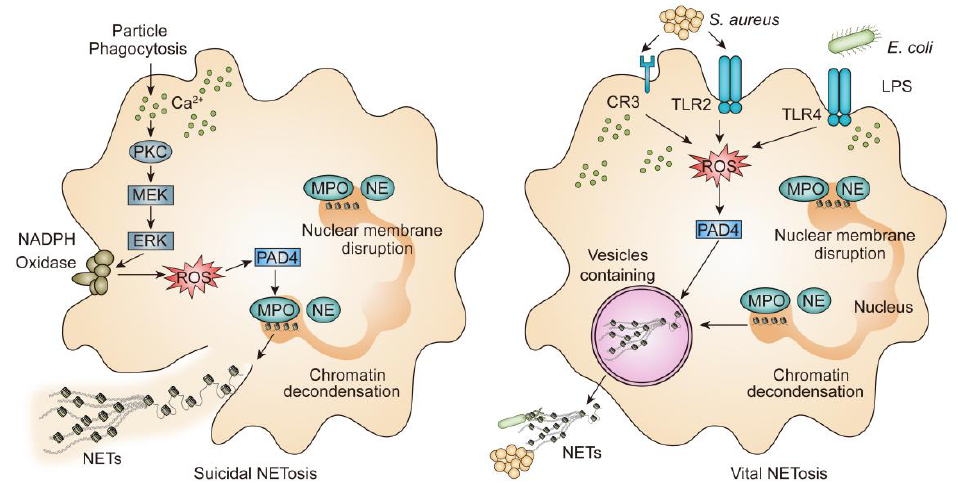
Figure 1. Mechanisms of NETs production were